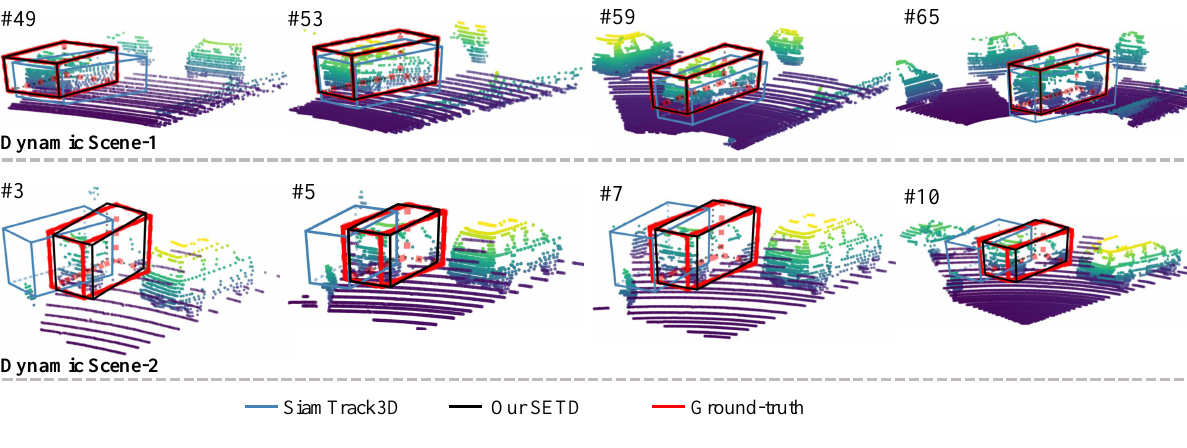
Figure 6. Visual results in terms of dynamics. We show two dynamic scenes. When the target ran at a high speed (dynamic), our SETD obtained better results, whereas SiamTrack3D resulted in significant